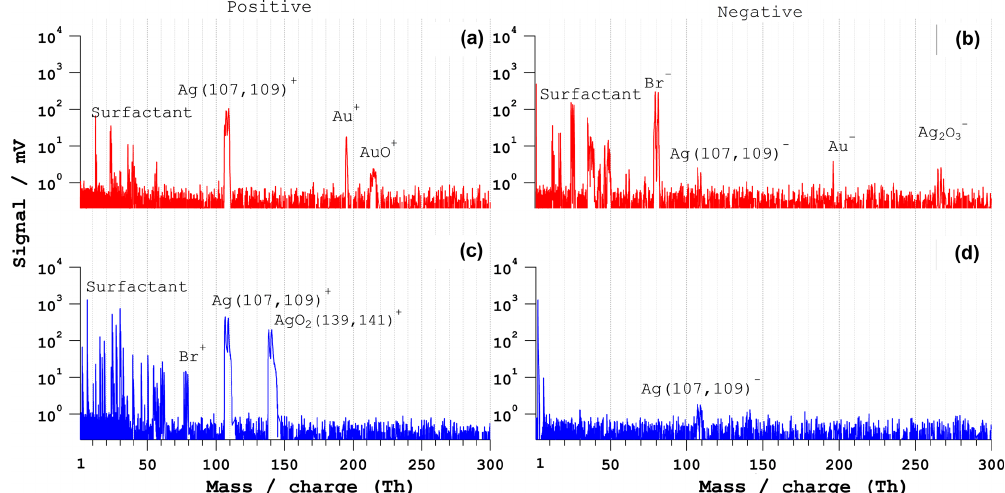
Figure 7. Bipolar mass spectra of gold–silver core-shell particles of d p = 600nm. (a, b) Typical ns-LAAPTOF spectra and (c, d) fs- LAAPTOF ( λ = 800nm) spectra. The pulse energy is 4mJ for the ns laser and 3.2mJ for the fs